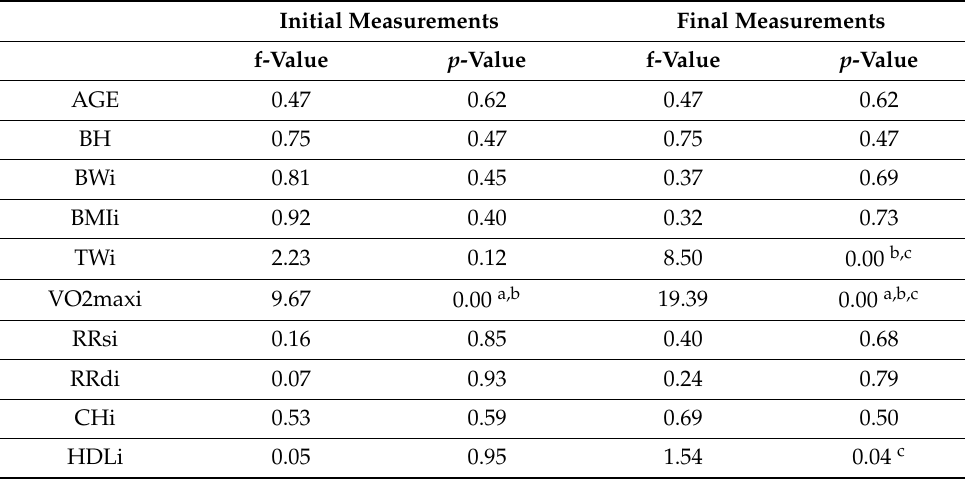
Table 4. Differences in all three groups in initial and final